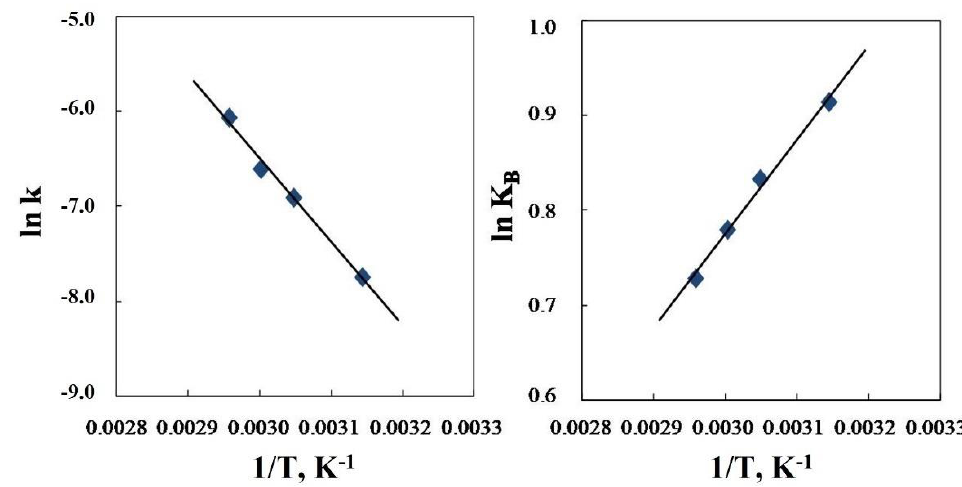
Figure 9. Influence of temperature on transesterification kinetics by using NaNO 3 /SiAl 20/1. Linear adjustment through Arrhenius ( left ) and Van’t Hoff ( right ).